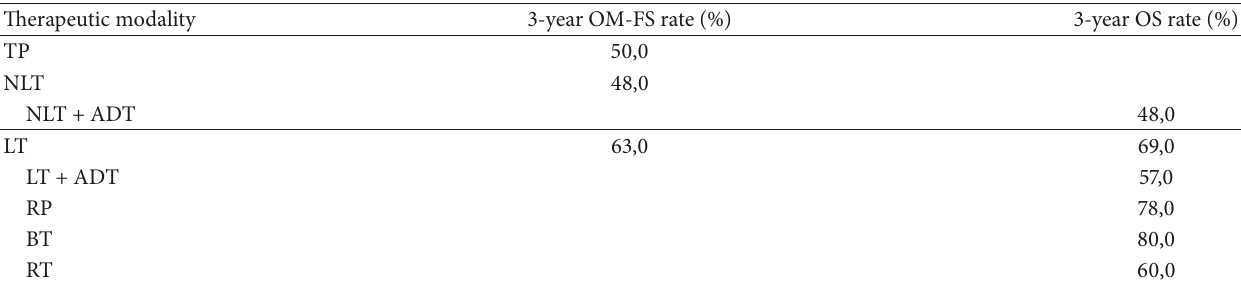
Table 6: Overall mortality-free survival and overall survival by therapeutic modality, adapted from L¨oppenberg et al. (2016) [14]. Therapeutic modality